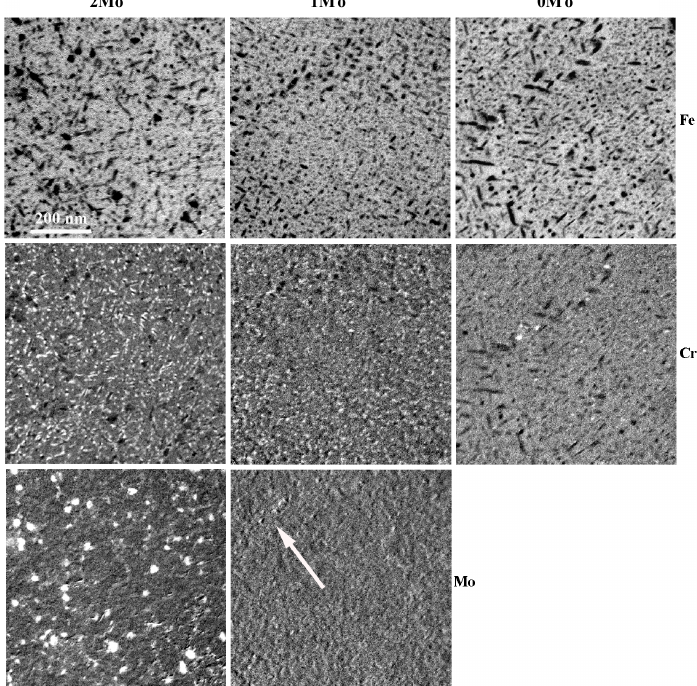
Figure 7. Energy filtered transmission electron microscopy (EFTEM) jump-ratio images of materials aged for 100 h at 475 °C, with white representing a high concentration and black a low concentration. The arrow marks a few occasional Mo-rich precipitates in 1Mo.